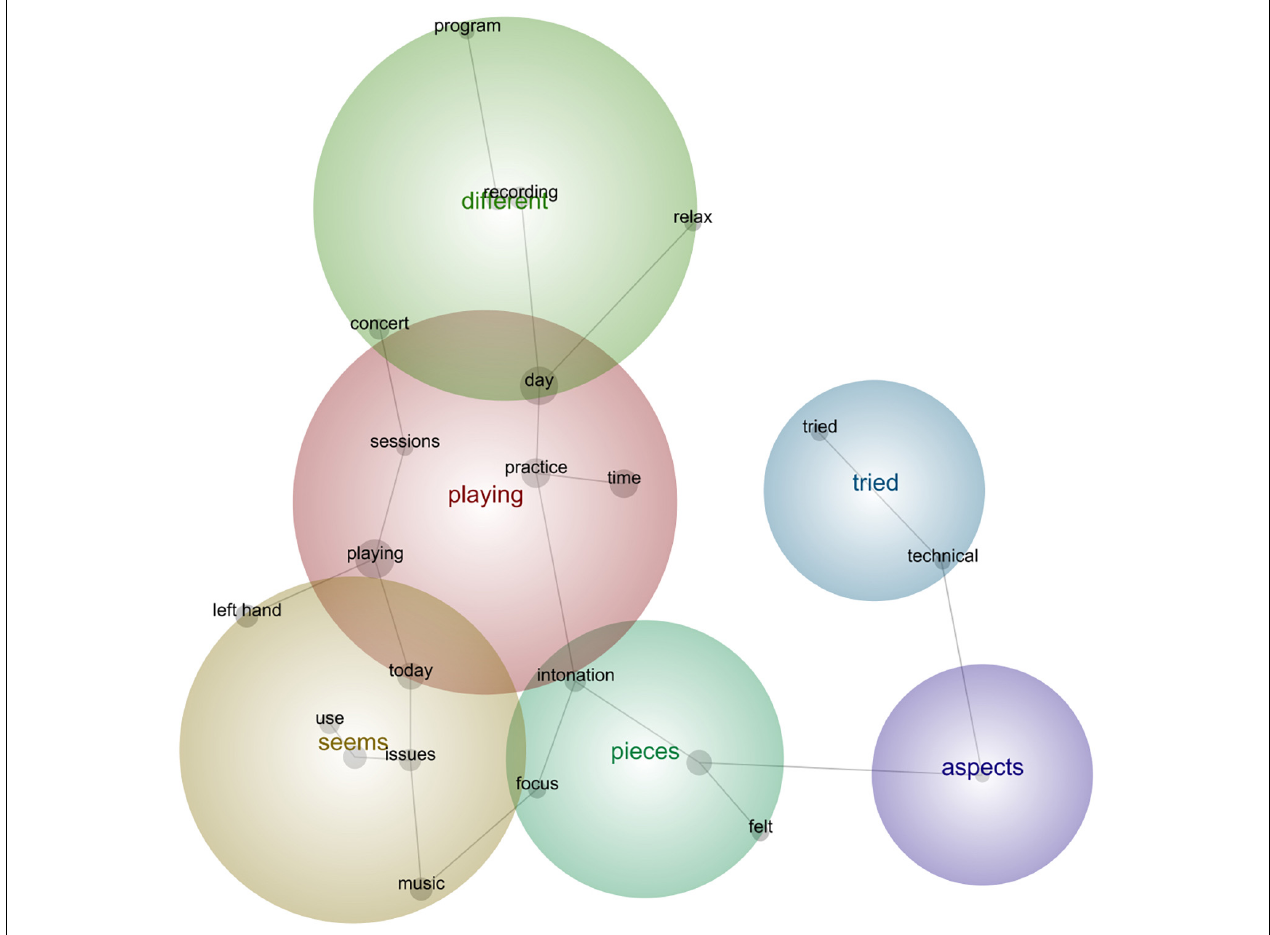
FIGURE 11 | Leximancer concept map for Concert